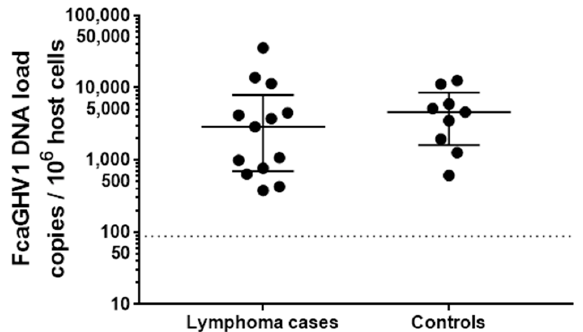
FFPE = formalin-fixed, paraffin embedded. Table 2. Paired-sample combinations analysed for FcaGHV1 DNA distribution in lymphoma compared to autologous non-lymphoma tissue using McNemar’s exact test. Lymphoma Tissue FcaGHV1 Positive